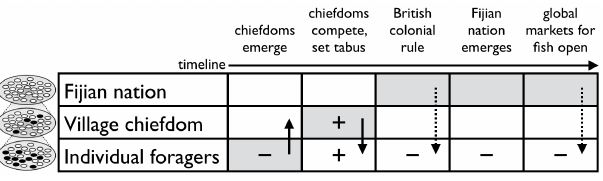
Fig. 3 . Traditional fishing restrictions in Fiji may have lessened because of a change in the dominant level of selection. Before colonial rule, traditional chiefly fishing bans may have been supported by competition between groups. Following colonization, village level organization weakened, and Fiji began to compete as a nation in global fish markets. Individual competition for fish resources is higher, and village competition for income also drives fishing efforts. Unrestrained harvest (–), harvest restraint or limits (+), collective action ( ↑ up arrow), group reinforces harvest restraint ( ↓ down arrow), group weakens harvest restraint (dotted down arrow). Shaded cells represent dominant level of